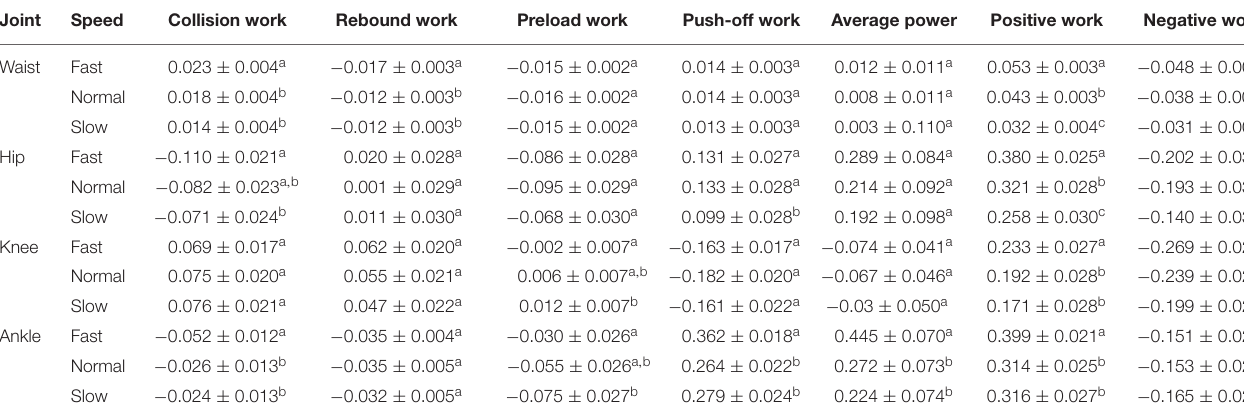
TABLE 1 | Mechanical work produced by joints during different phases.